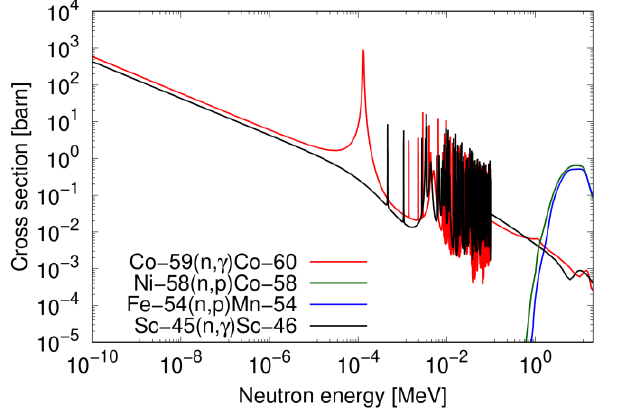
Fig. 7 Cross sections for reactions produced by DD and DT neutrons. All cross sections are taken from the IRDFF-II nuclear data library.